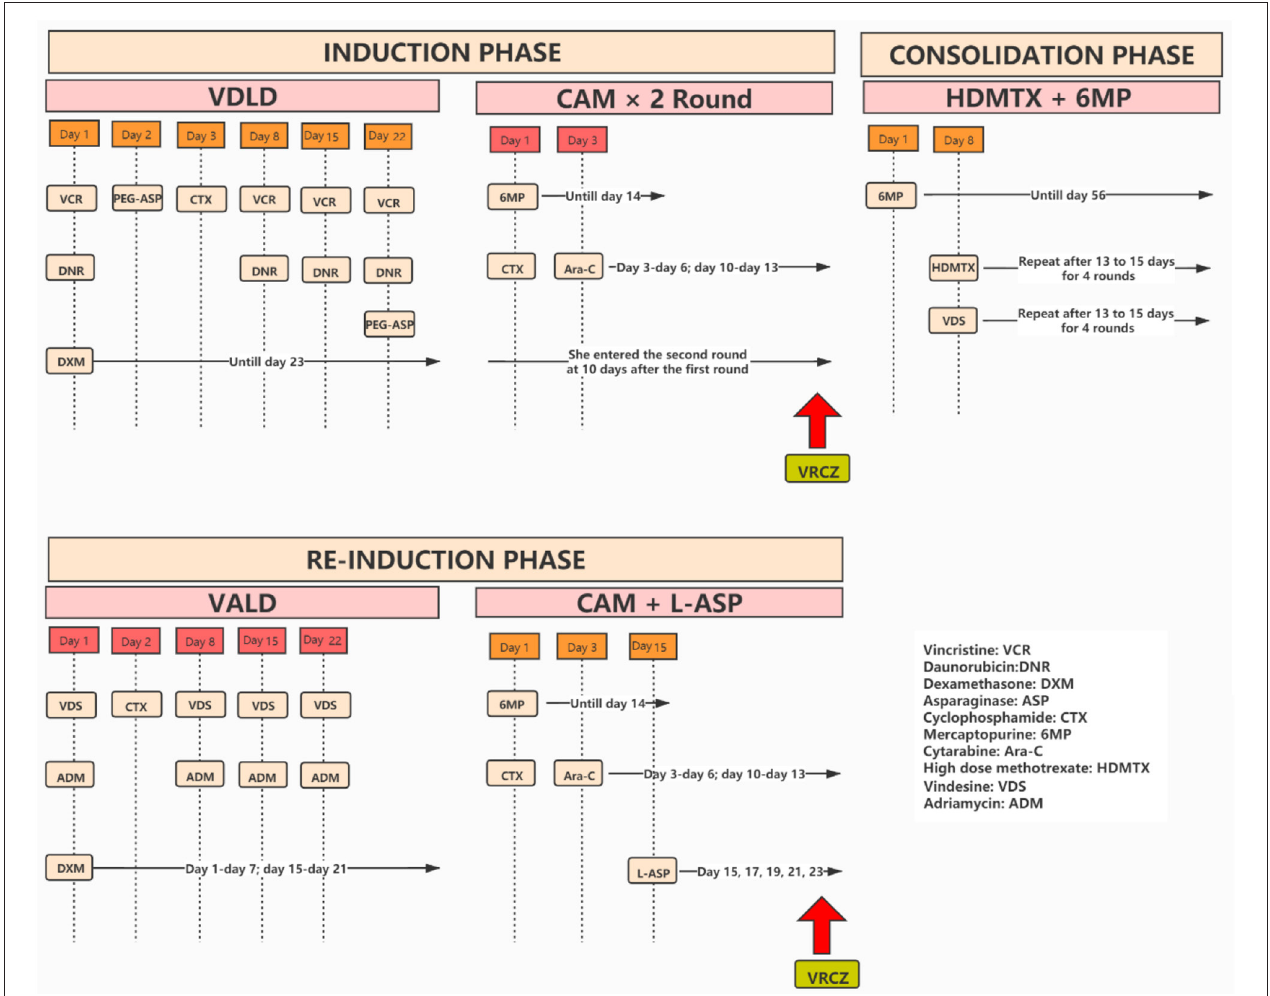
FIGURE 1 | The chemotherapy process in this